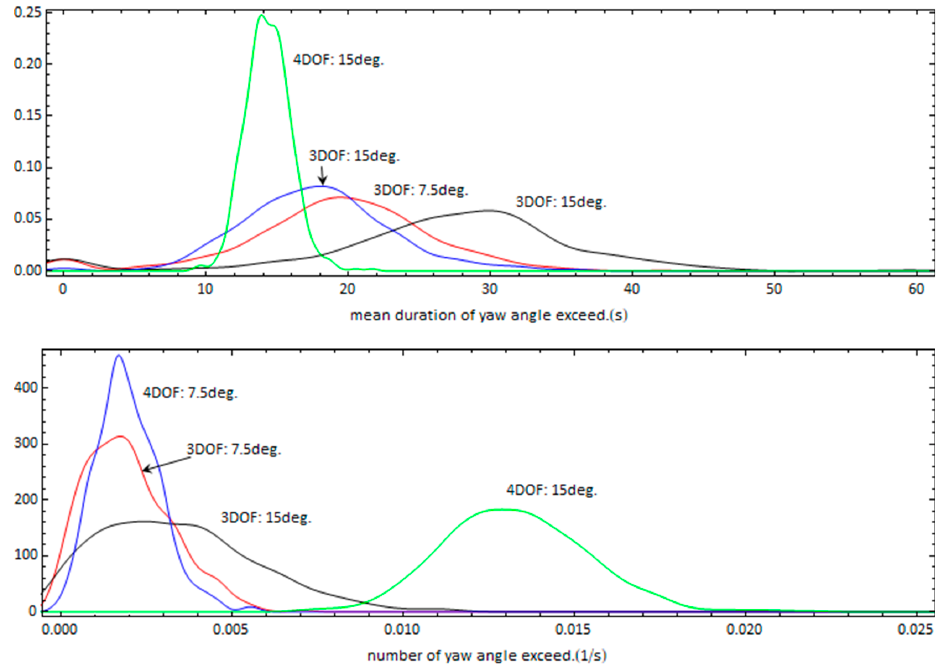
Figure 10. Probability density functions of the mean duration of yaw exceedance (upper graph) and number of exceedances per unit time (lower graph) for different commanded headings using the 3DOF and 4DOF models.